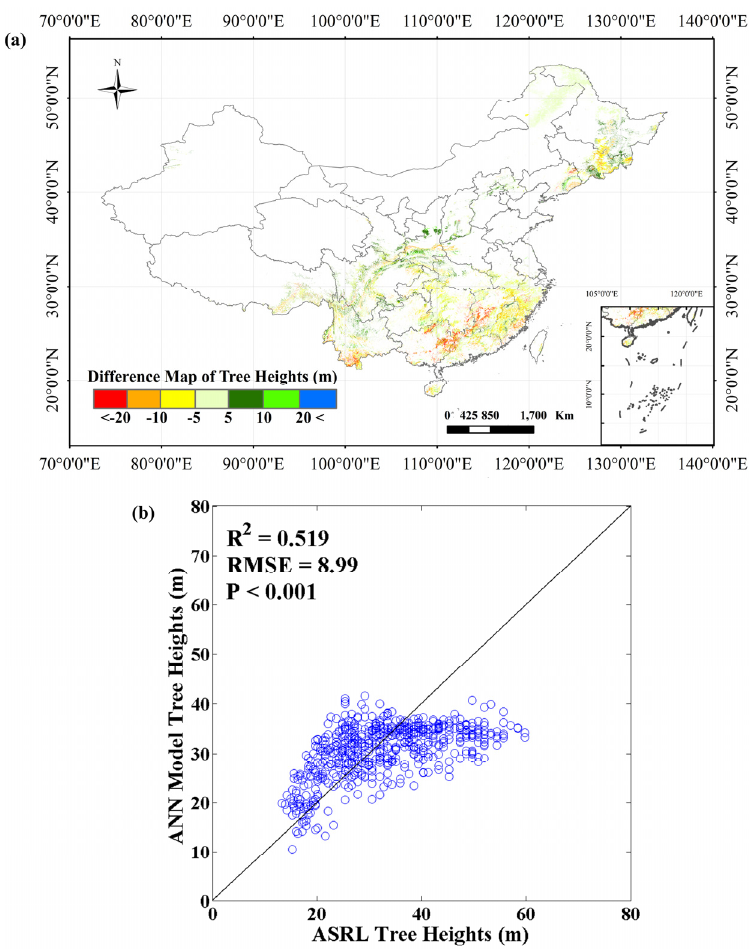
Figure 8. The comparison result between the modeled tree heights and the H Ni s. ( a ) The difference map of the modeled tree heights against H Ni ; ( b ) the comparison between the modeled tree heights and H Ni